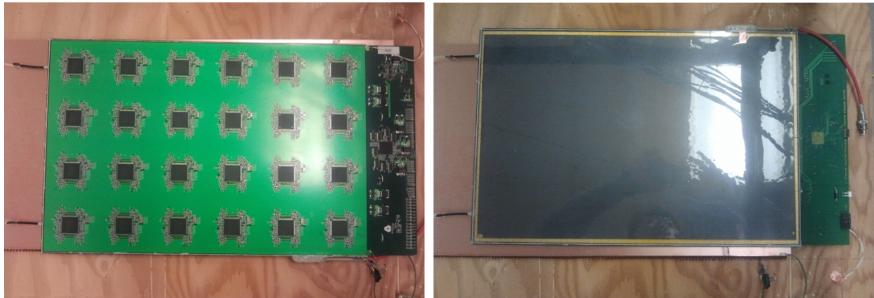
Figure 2. Pictures of the readout ( left ) and front ( right ) side of the 1-glass RPC. The readout side picture depicts the array of the DCAL chips and the data concentrator circuitry of the digital readout. The front side picture depicts the cathode glass covering the entire area of the 1 cm × 1 cm